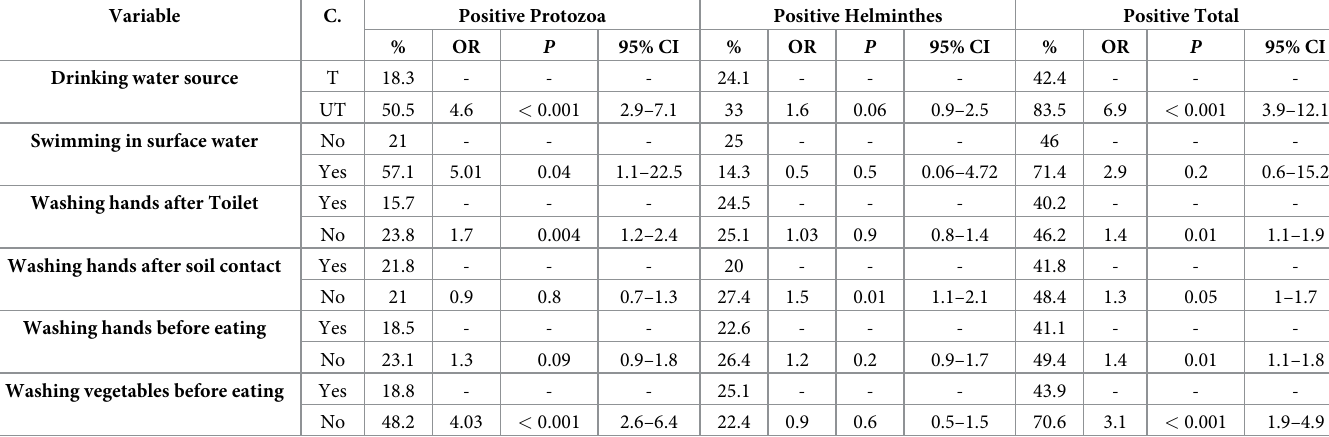
Table 4. Univariate regression analysis for association between high risk practices and prevalence of detected IPIs in examined children in this study.